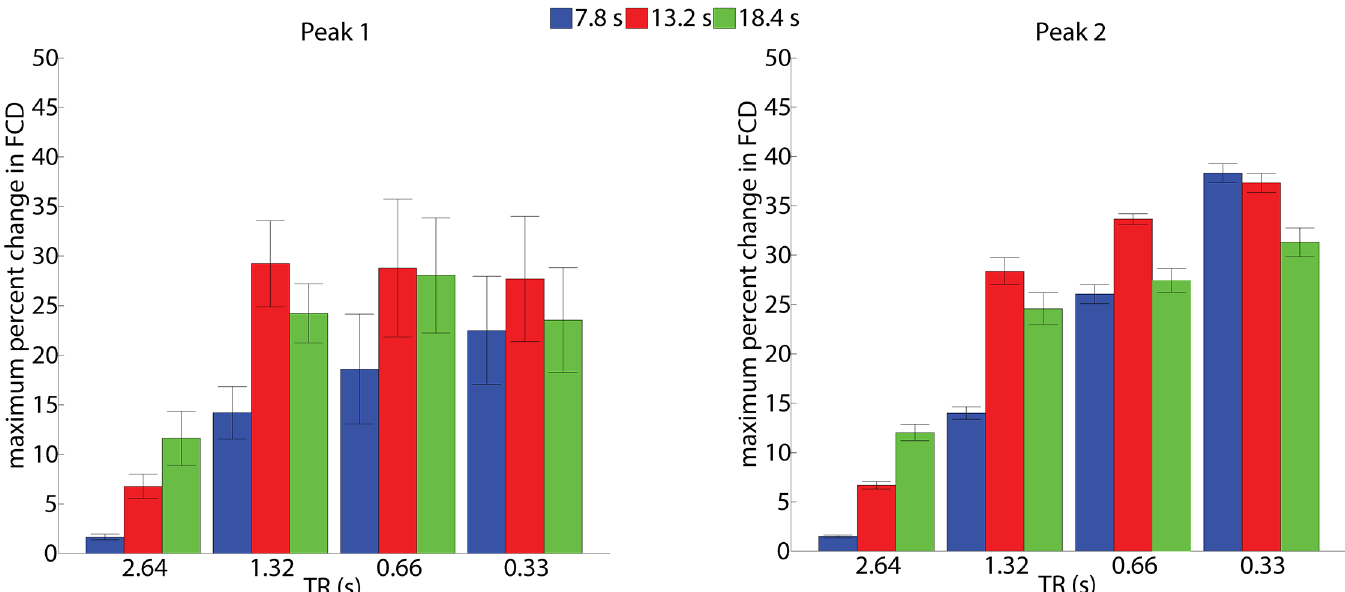
Fig 3. Maximum percent change in FCD across TRs and window sizes. Maximum percent change of FCD during the event-related task in the ROI, for peak 1 and peak 2 across window sizes of 7.8 s, 13.2 s and 18.4 s at TRs ranging from 2.64 s to 0.33 s.